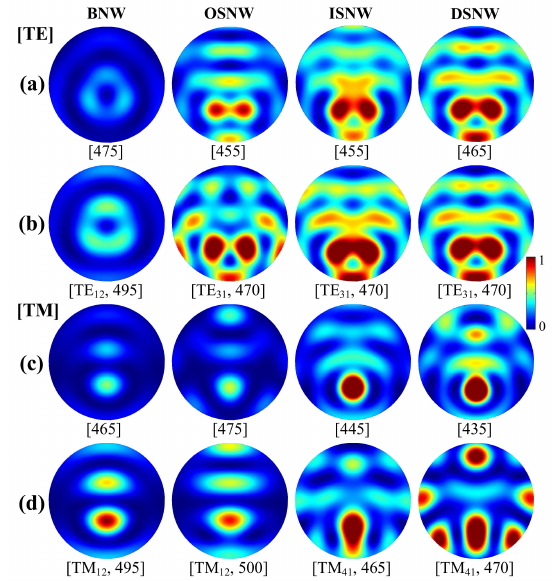
Figure 3. The representative normalized absorption mode profiles inside the Si core corresponding to the wavelengths in Figure 2c,d [from left to right columns are associated with the BNW, OSNW, ISNW and DSNW, respectively]: ( a , b ) for TE and ( c , d ) for TM light illumination; ( a , c ) for o ff -resonant and ( b , d ) for resonant wavelengths. Note that the numbers in square brackets are the wavelengths and the modes of the the leaky mode resonances (LMRs) at the resonant wavelengths are also labeled in the left of square brackets in Figure